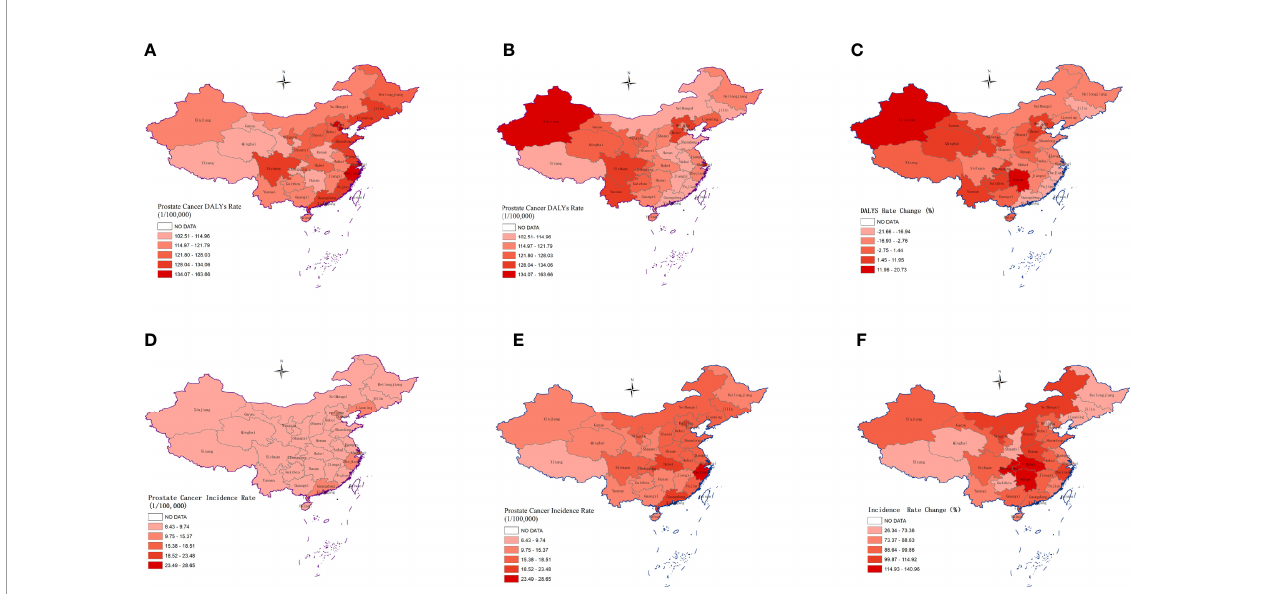
FIGURE 3 | The age-standardized incidence rate of Prostate Cancer in 33 provinces of China in 1990 (A) , 2019 (B) , and the percentage change of incidence (C) . The age-standardized DALYs rate of Prostate Cancer in 33 provinces of China in 1990 (D) , 2019 (E) and the percentage change of incidence (F)